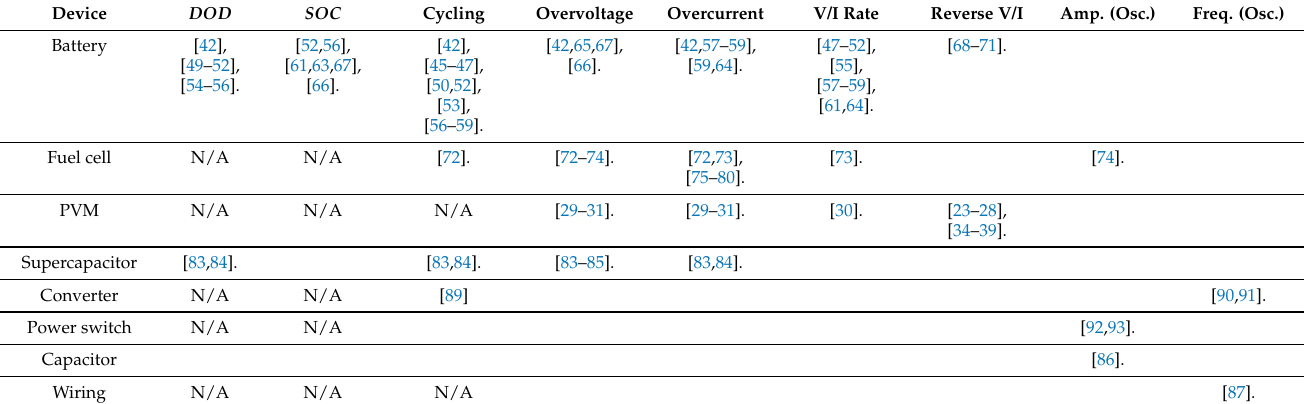
Table 9. Summary of electrical-stressors studies for relevant smart grid